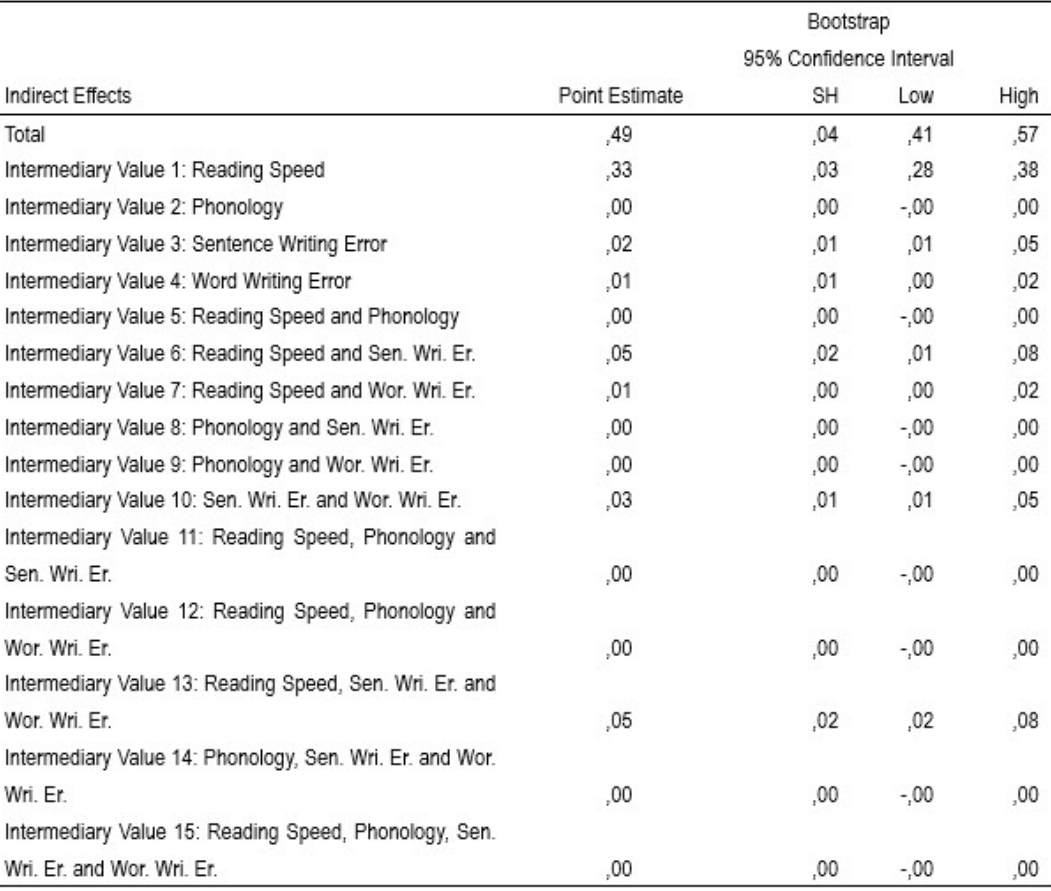
Indirect effects of visual perception on reading errors via reading speed, phonological awareness, word, and sentence writing errors